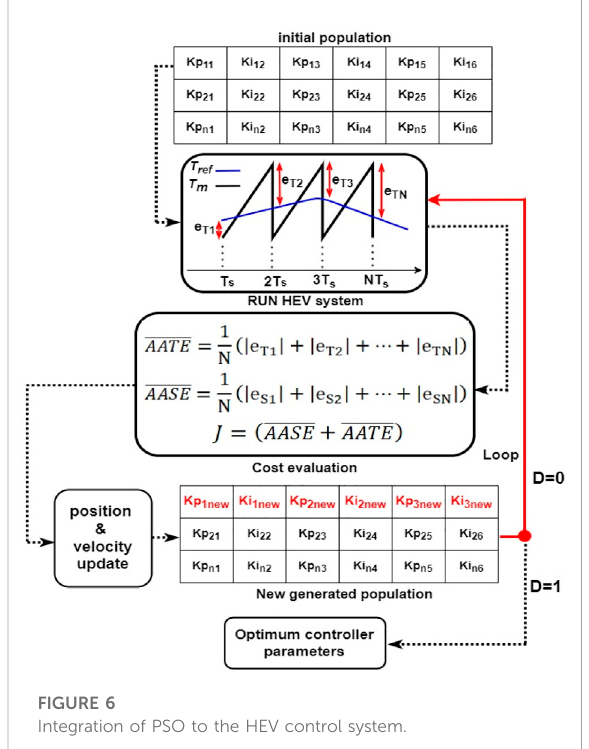
FIGURE 6 Integration of PSO to the HEV control system.